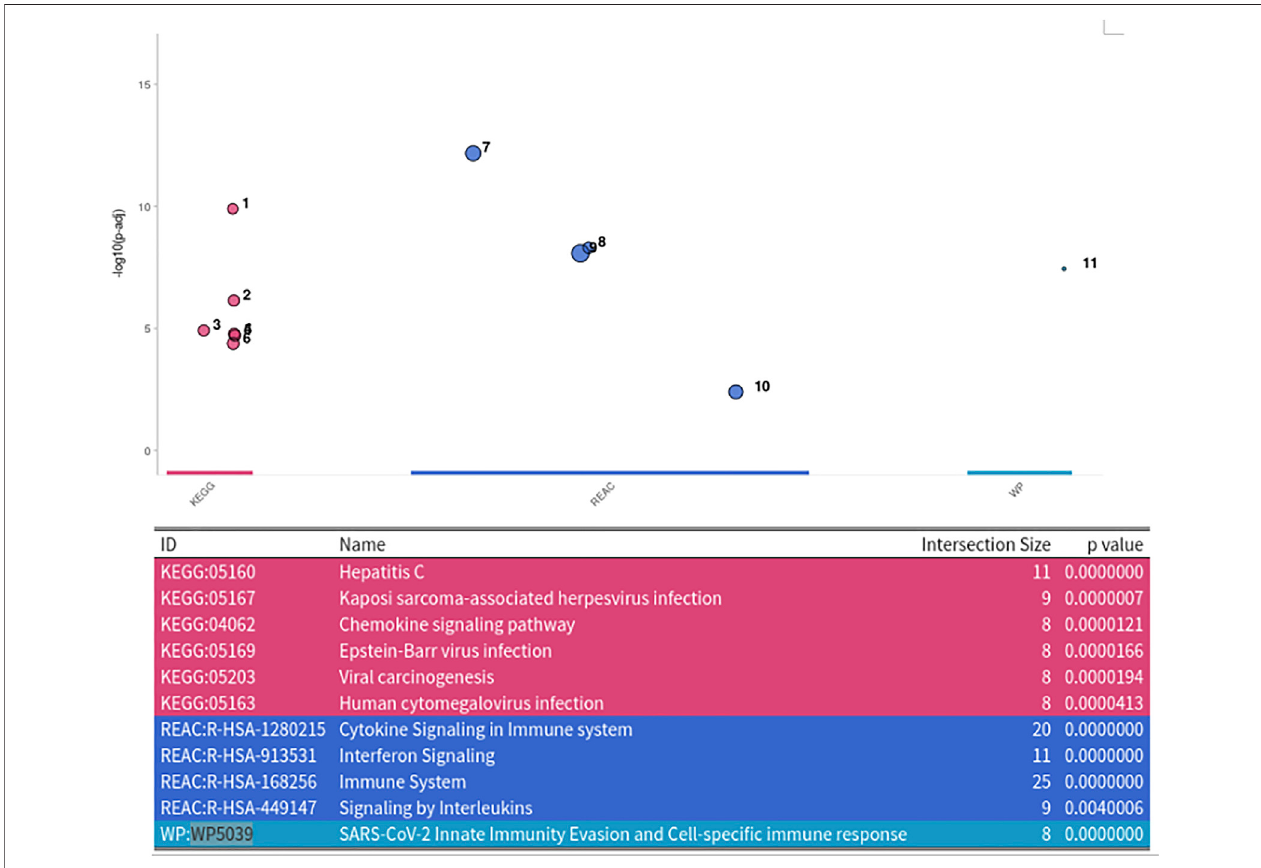
FIGURE 5 | Enrichment Analysis of extracted SARS-CoV-2 network. The network was tested for enrichment within the KEGG, Reactome and Wikipathways data bases.